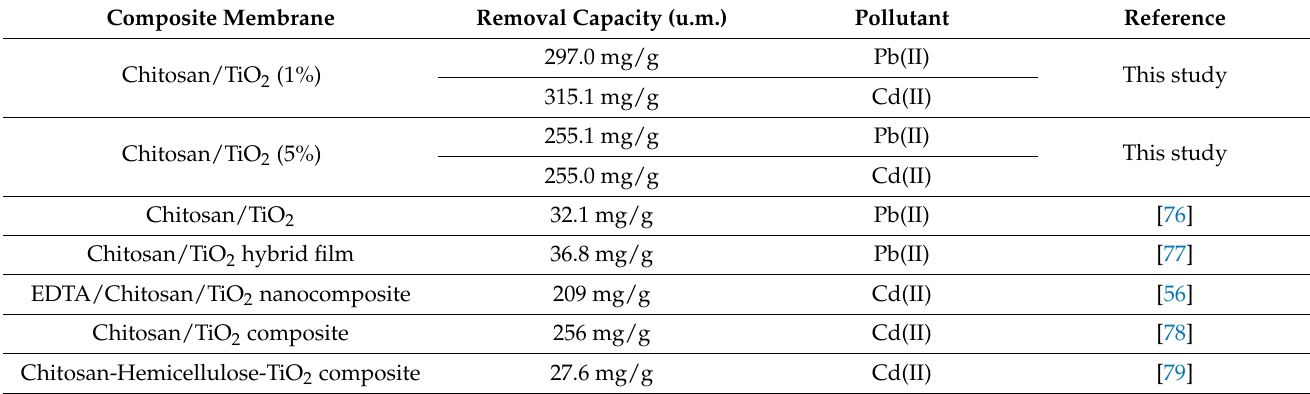
Table 4. Comparison with previously reported results from literature for chitosan/TiO 2 membranes. Composite Membrane Removal Capacity